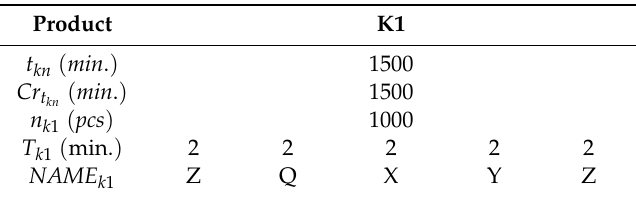
Table 5. The input values for the product K1.